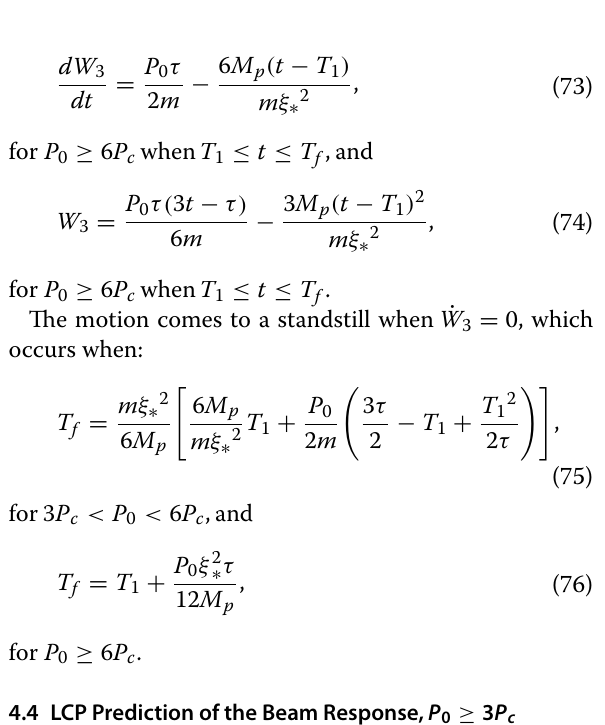
Fig. 13 indicates the evolution of the non-dimensional maximum central displacement at ξ ∗ (Fig. 8) through- out Phases 1 and 2 of motion for the pulse magnitude P 0 = 12.5 P c . It is evident that the LCP results agree sub- stantially with the theoretical solution.